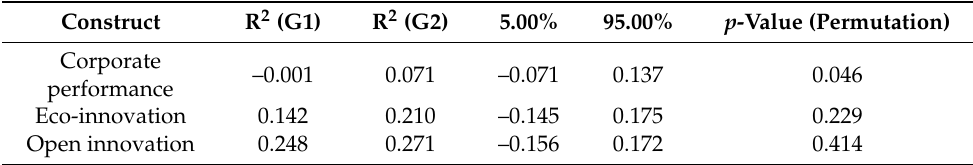
Table 11. Adjusted R 2